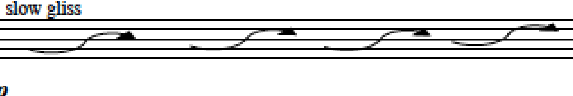
Figure 9. S-shaped